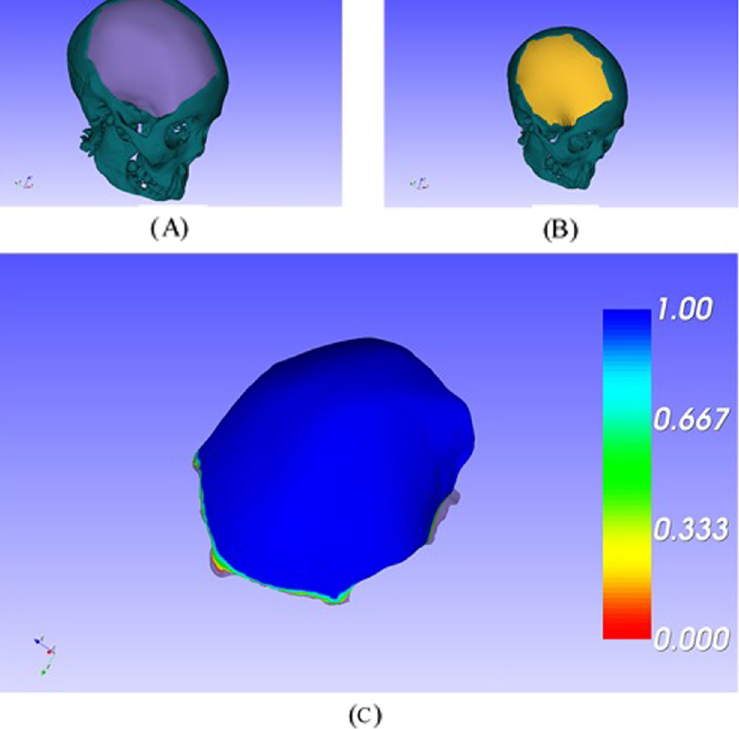
Figure 3. The comparison between the implants designed using EasyCrania and traditional softwares: ( A ) the implant designed using EasyCrania, ( B ) the implant designed using traditional softwares, ( C ) the distance filed between the two